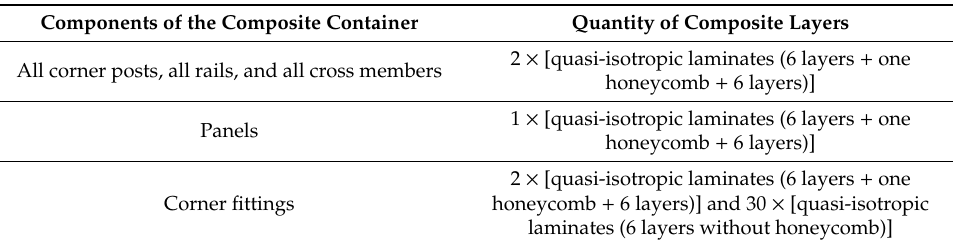
Table 2. Quantities of composite layers used.